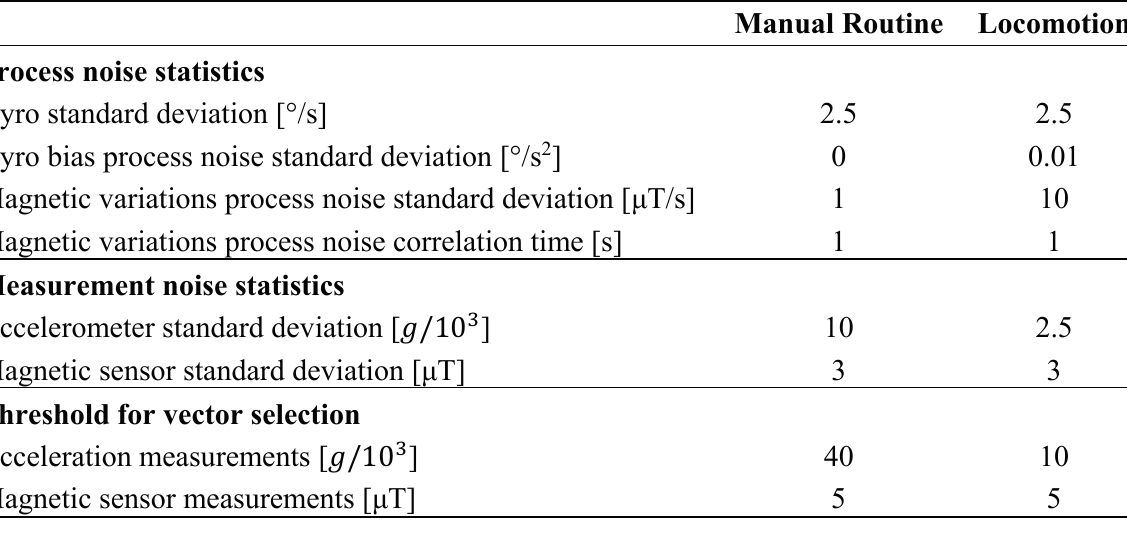
Table 1. Input parameters for the SF